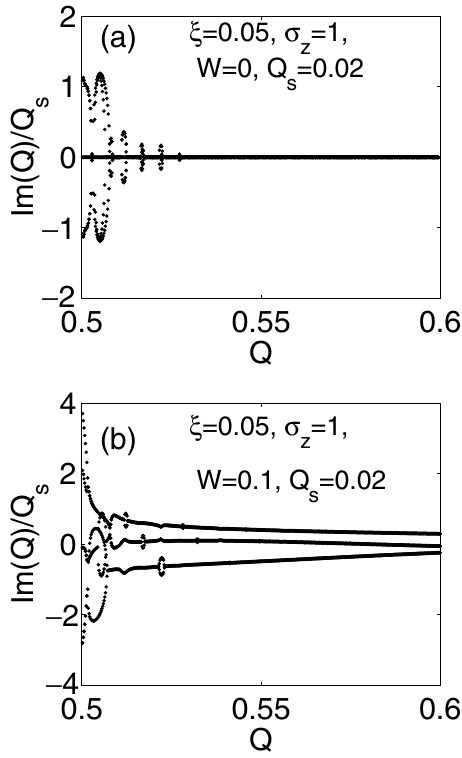
FIG. 1. Dependence of the imaginary part of the eigentunes on the betatron tune. The eigentunes are normalized by the . Beam-beam parameter is chosen to be synchrotron tune Q s 0.05. (a) and (b) are for W (cid:4) 0 and W (cid:4) 0 : 1 , respectively.